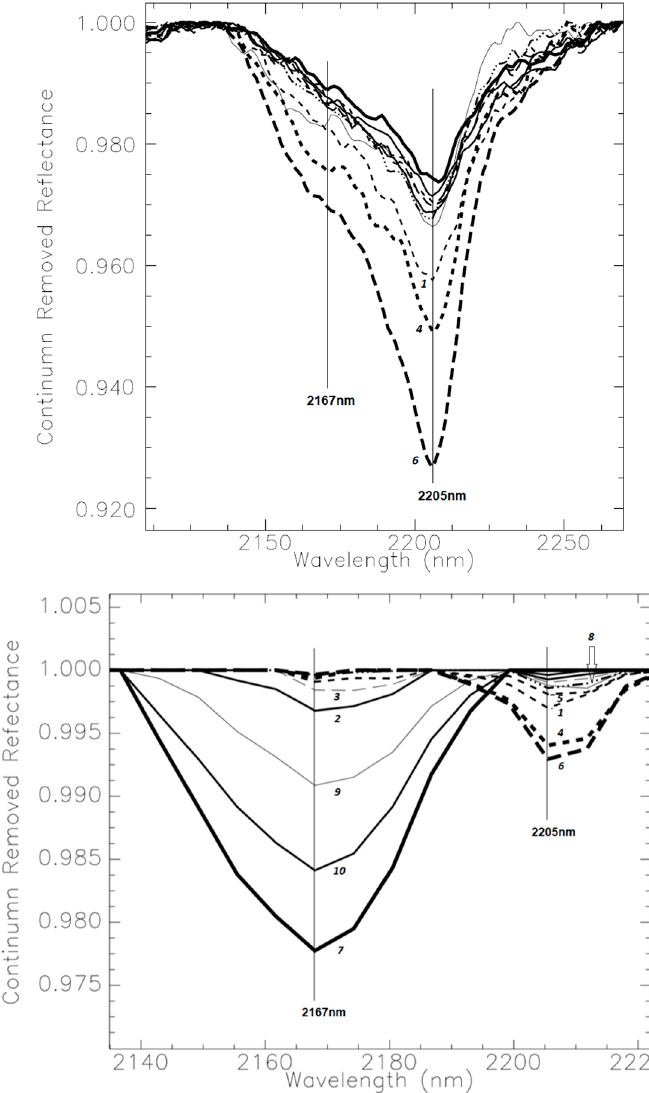
Figure 8. Average spectra of froth and froth solids displayed with the continuum removed to highlight the presence of absorption features centered at 2167 nm for kaolinite and 2205 nm for illite-smectite clays. Top : average point spectrum of 3 footprints of froth solids. Bottom : mean spectrum from froth imagery encompassing more than 10,000 pixels.